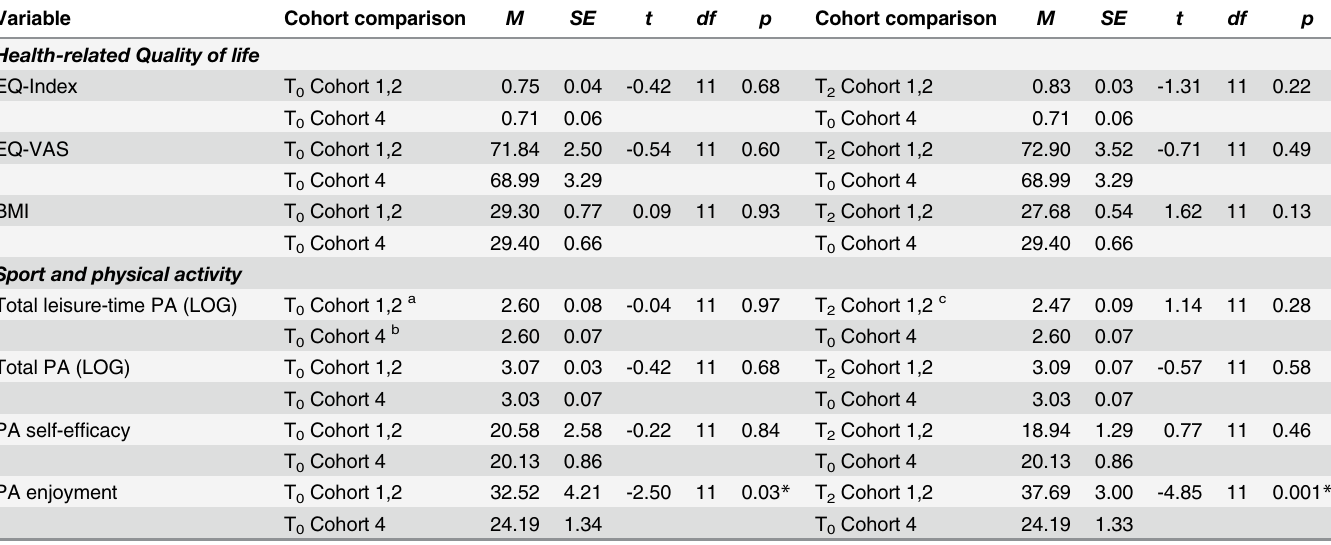
Table 5. Group means comparison for cohorts 1, 2 and 4 at baseline (T 0 ) and at twelve months (T 2